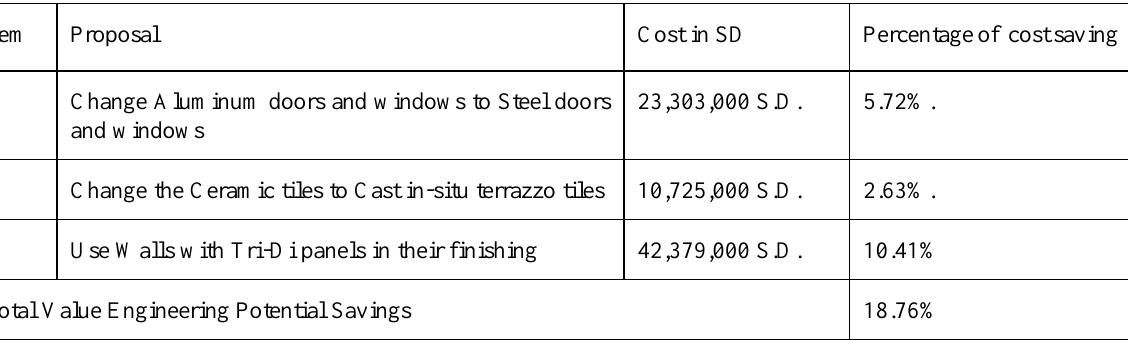
Table 4. Summary of the outcome of VE on example (B). Source: Bashir, 2015.